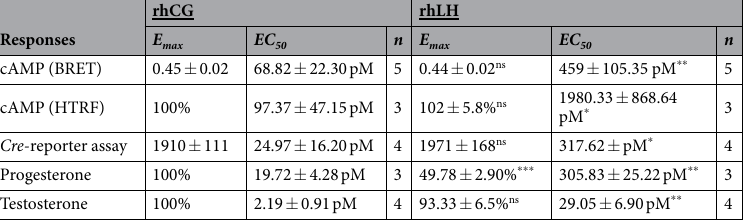
Table 2. Efficacy ( E max ) and efficiency ( EC 50 ) of rhCG and rhLH on LHR measured in different assays in mLTC-1 cells. The E max values are represented as hormone-induced BRET changes (for cAMP by BRET), % of rhCG-induced response (for cAMP by HTRF, progesterone and testosterone) and relative luciferase activity (for Cre -reporter assay). Statistical analyses were performed with unpaired t-test ( *** p < 0.001; ** p < 0.01; * p < 0.05, ns non-significant) .